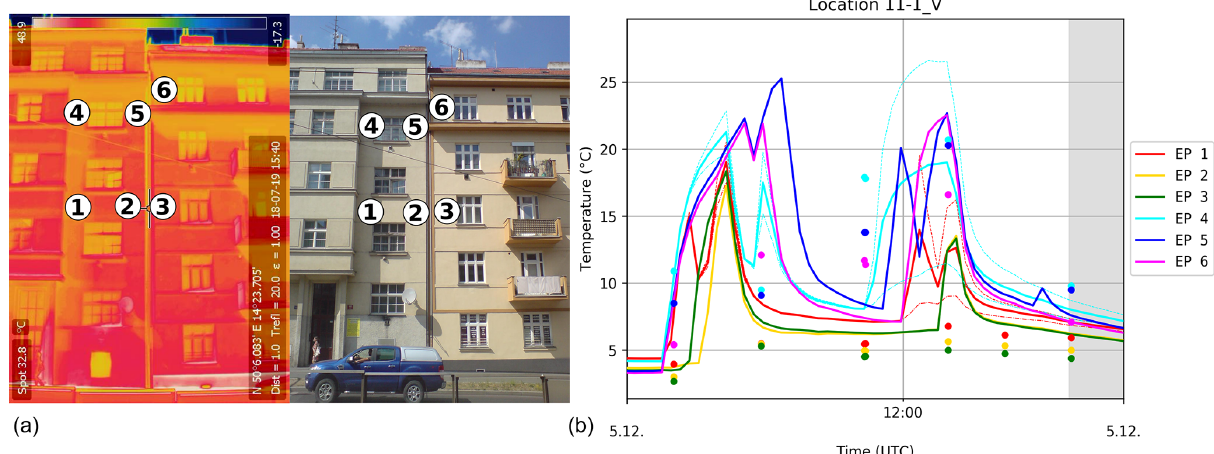
Figure 20. Comparison of IR observations and the model at location 11-1_V on 5 December 2018 from 07:00 to 16:00UTC. The left photos show IR and RGB images of the location with the evaluation points marked, and the right image shows the graph of the modelled (line) and observed (dots) values of the surface temperature for these evaluation points. The grey area denotes